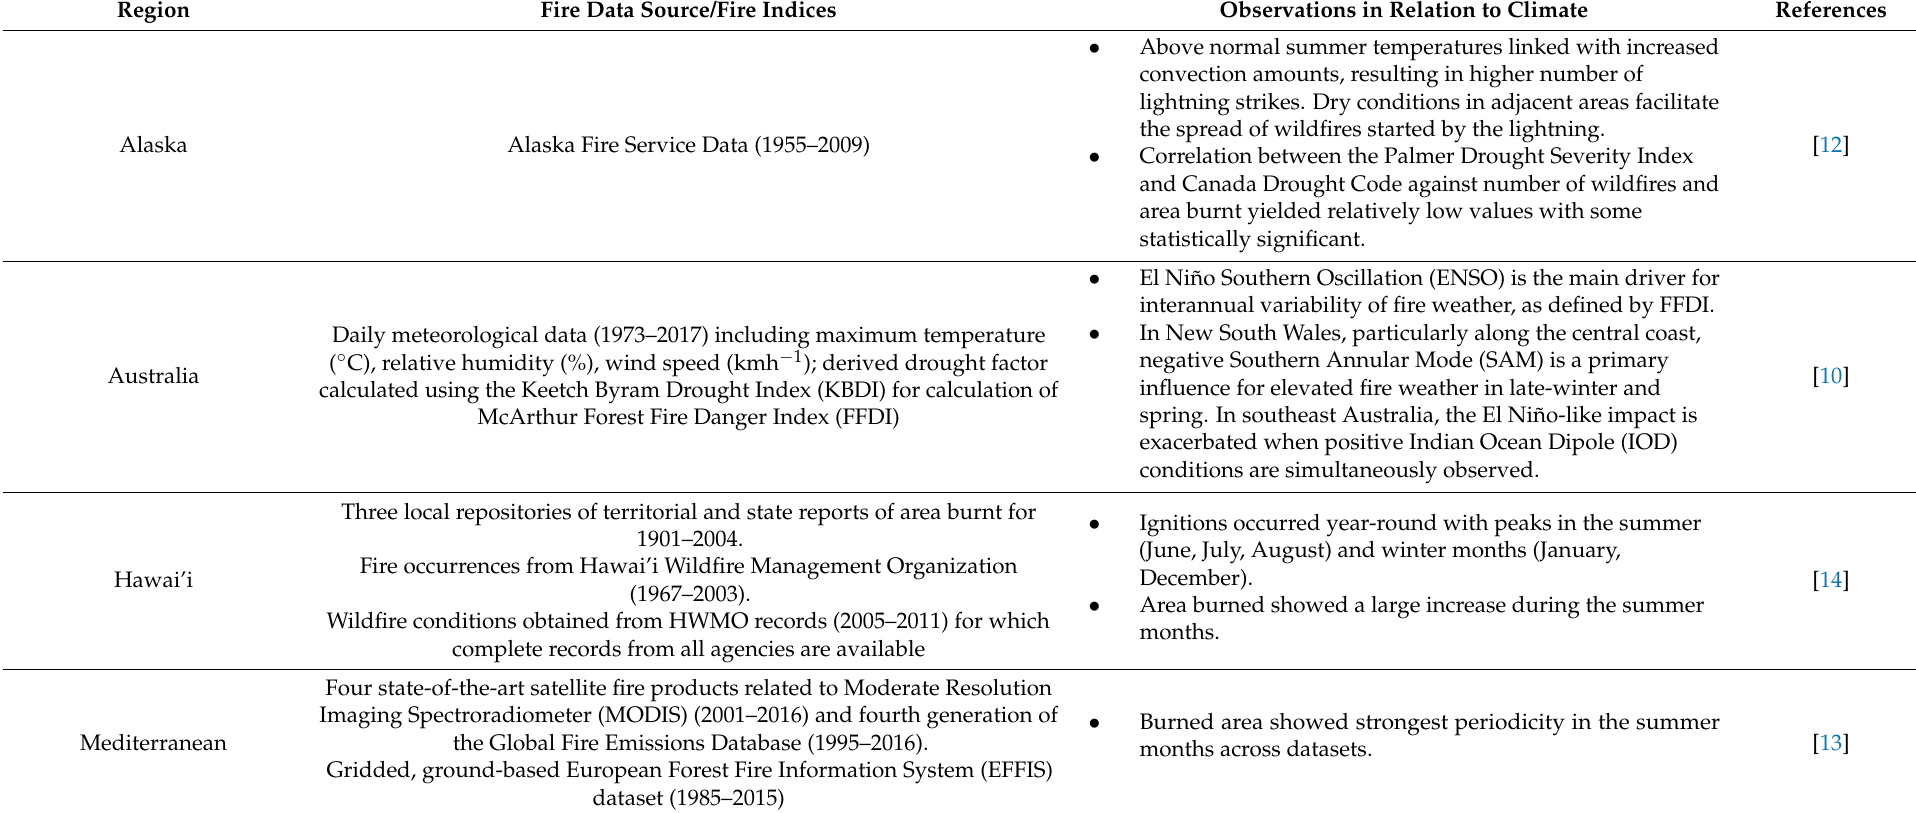
Table 2. Fire characteristics and their relation to climate for some regions. Data sources and references are also shown.